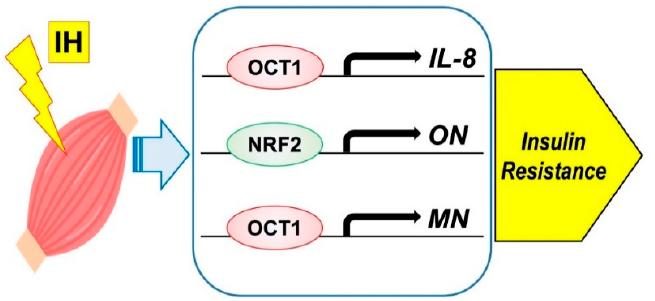
Figure 3. Possible mechanism on IH-induced insulin resistance via myokine expression in muscle cells. IH significantly increased the mRNA levels of IL-8 , ON , and MN . The promoters contain con- sensus transcription factor binding sequences Figure 1 in IL-8 and MN , and for NRF2 in ON , respec- tively.